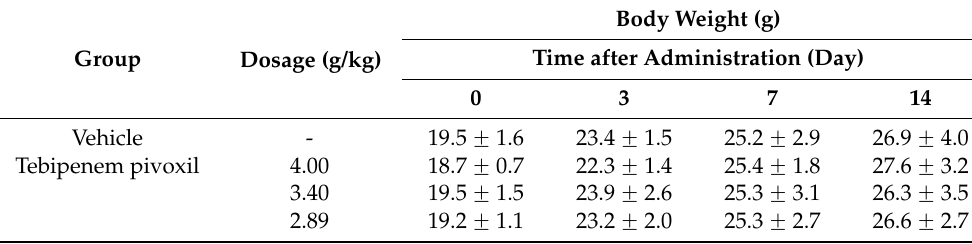
Table 5. Incidence of toxicity in liver and kidney after oral administration of tebipenem pivoxil. Liver Toxicity Kidney Toxicity Reagent Dosage (g/kg) Present Absent Present Absent Tebipenem pivoxil